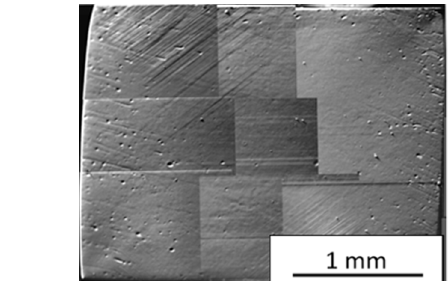
Figure 15. Deformation patterns on neighboring {100} lateral faces of a <001> Ni single crystal with h/d = 2. Compression was carried out along the <001> axis; ε = 22%.